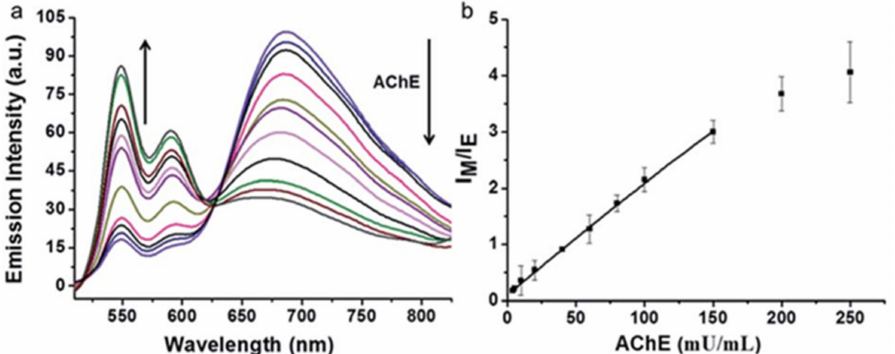
Figure 26. ( a ) Fluorescence response of probe 10 (10 µ M) in MOPS (pH 7.4) solution with lauroyl- choline (130 µ M) and lauric acid (300 µ M) to AChE (5–250 mU/mL). ( b ) Plot of F monomer / F excimer (I M /I E ) value vs. AChE concentration (5–250 mU/mL) [72].